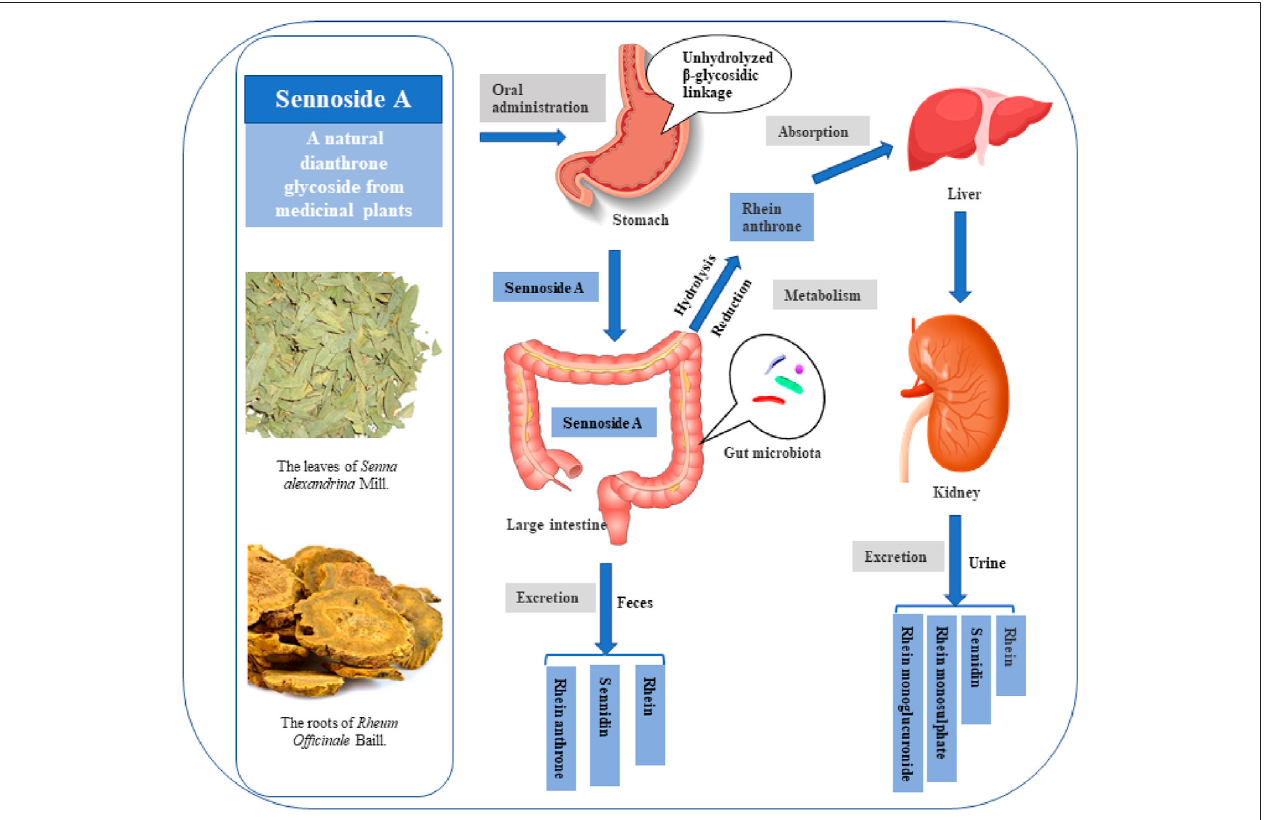
FIGURE 4| Possible metabolic patternof sennoside Aafter oral administration. SA pass the stomach and small intestinewithout transformation and absorption. It is transformed to rhein anthrone by intestinal fl ora in the large intestine and therefore absorbed into enterohepatic circulation. Finally, the metabolites of SA are excreted through urine and